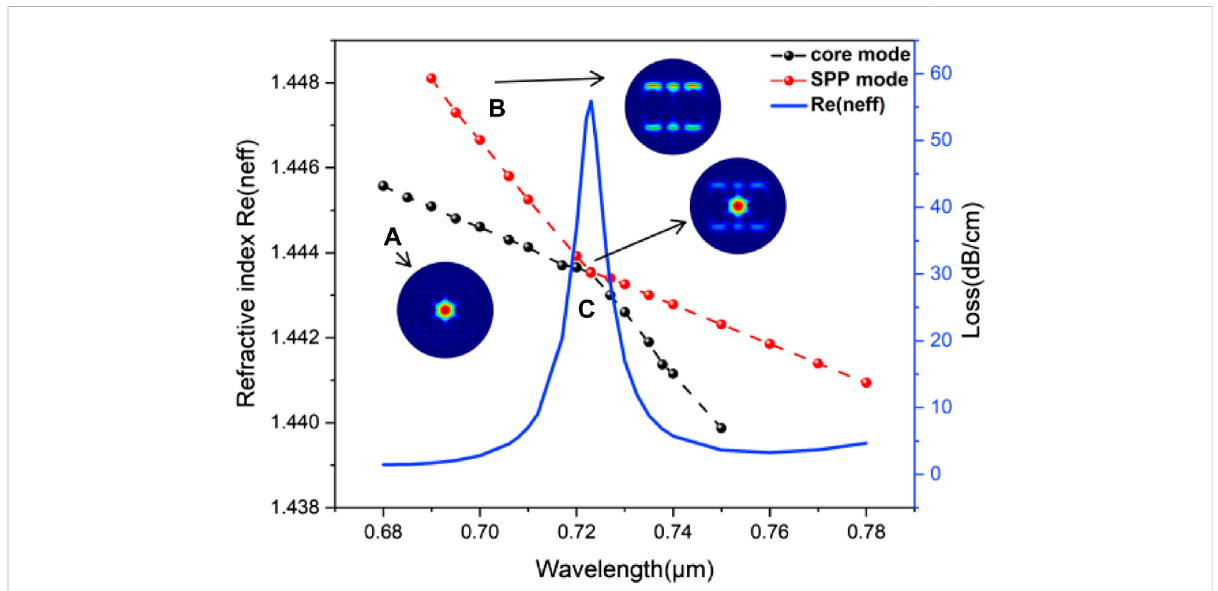
FIGURE 2 Dispersion relation of the core mode and the SPP mode and loss spectrum. Insets (A – C) : Energy distribution at each